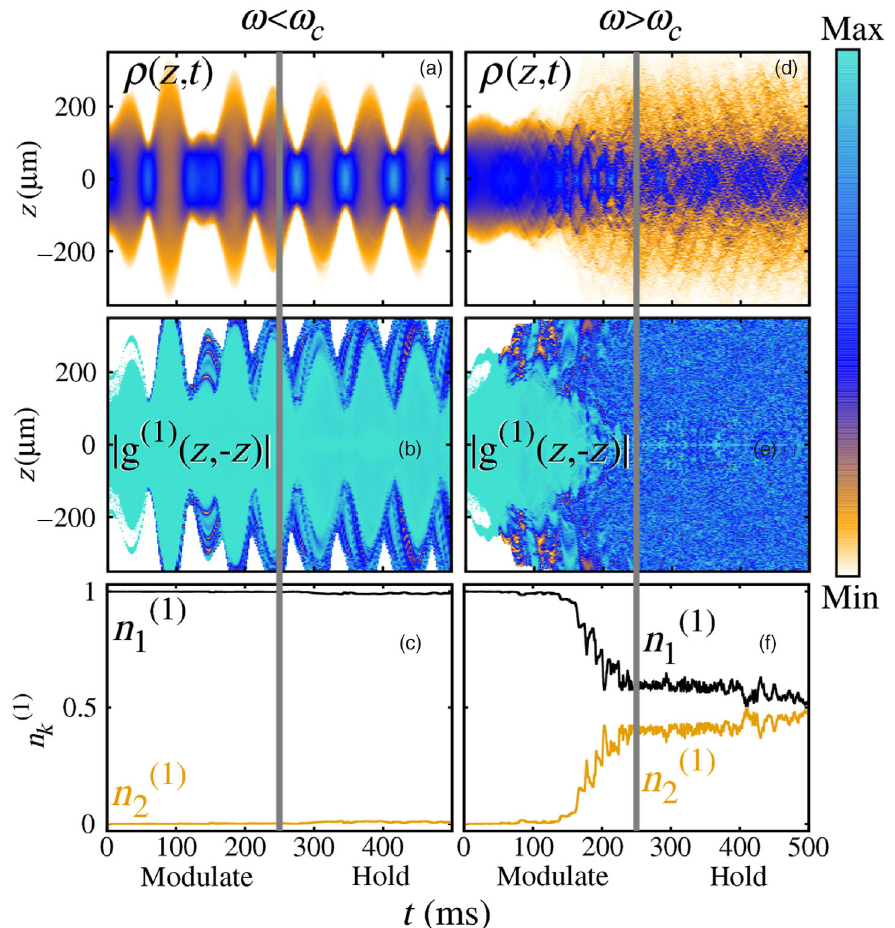
experiment.FIG. 10. Time evolution, coherence, and fragmentation from simulations. (a),(d) The density ρ ð z; t Þ , (b),(e) first-order spatial correlation function j g ð 1 Þ ð z; − z Þj , and (c),(f) natural occupations n is indicated by the yellow line. (a) – (c) are calculated with ω ¼ ð 2 π Þ 20 Hz < ω parameters are given in the caption of Fig. 7. The onset and formation of granulation are inferred by the simultaneous drop in the values ð 1 Þ of j g ð 1 Þ j and n 1 , indicating the emergence of spatial correlations and fragmentation,